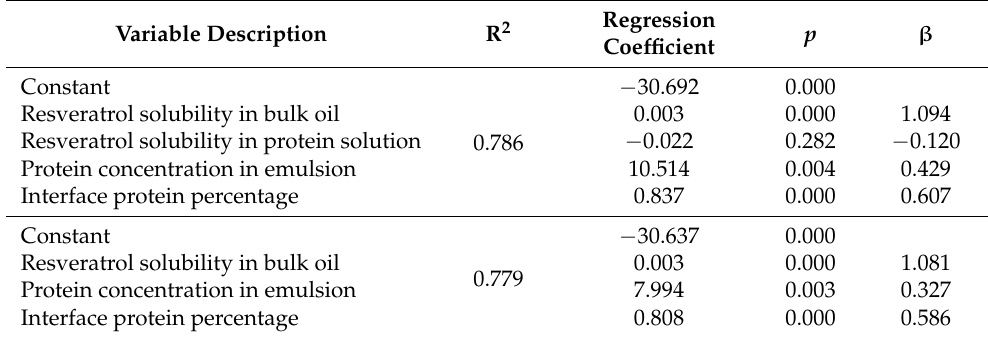
Table 3. Multiple linear regression analysis of the percentages of resveratrol in the oil phase of fish oil, sunflower oil, MCT and peppermint oil emulsions.